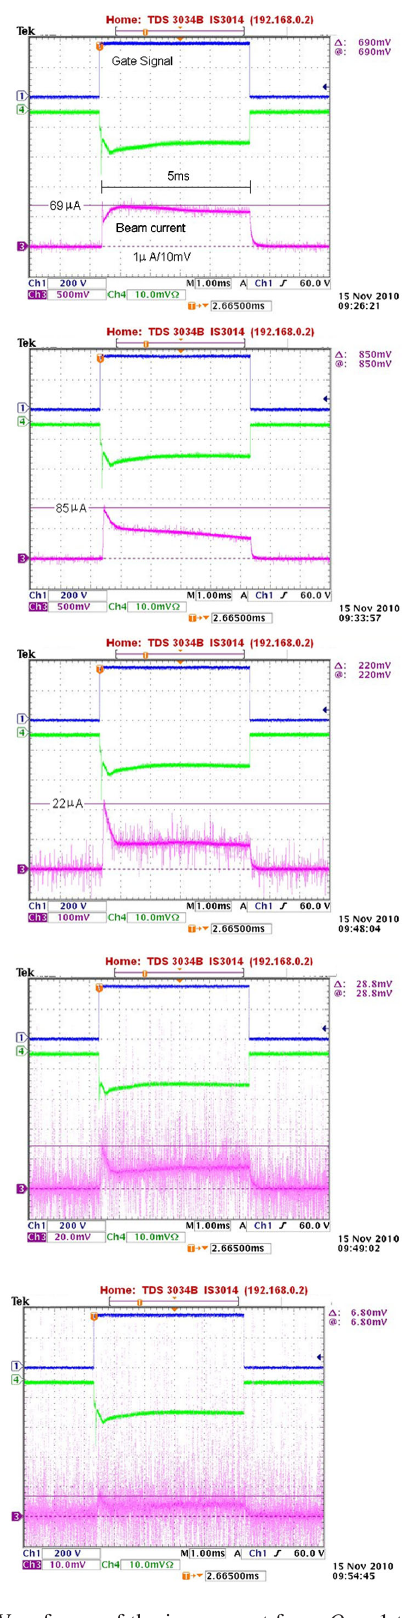
FIG. 7. Waveforms of the ion current from Q ¼ 1 to 5. Power/ pulse length: 600 W = 5 ms . Upper trace is the reflection signal of microwaves for